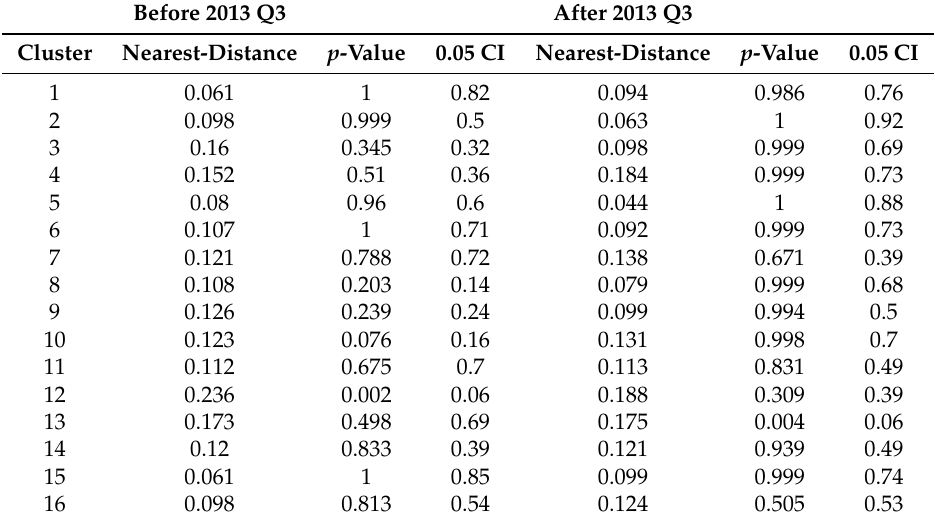
Table 2. Hausdorff